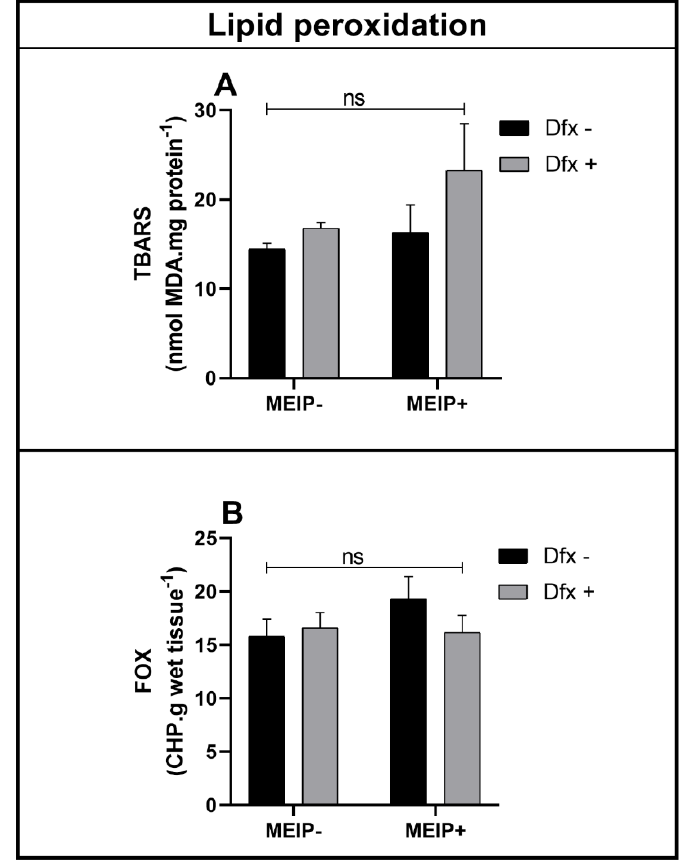
Figure 6. Lipid peroxidation by TBARS ( A ); FOX ( B ) on zebrafish brain exposed to Dfx supplemented of MEIP. Data are expressed by the mean ± SEM analyzed by ANOVA two-way with Tukey’s post-hoc test; ns = no significant .